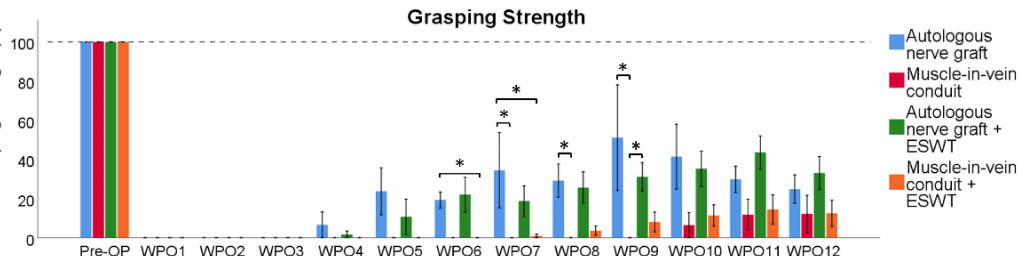
Figure 2. Recovery of grasping strength following reconstruction of the right median nerve. Statistical analysis was performed with the nonparametric Kruskal–Wallis test and the Dunn–Bonferroni post hoc test. Autologous nerve graft ( n = 3); muscle-in-vein conduit ( n = 5); autologous nerve graft with postoperative extracorporeal shockwave therapy ( n = 6); muscle-in-vein conduit with postoperative extracorporeal shockwave therapy ( n = 7). WPO: postoperative week; * p <